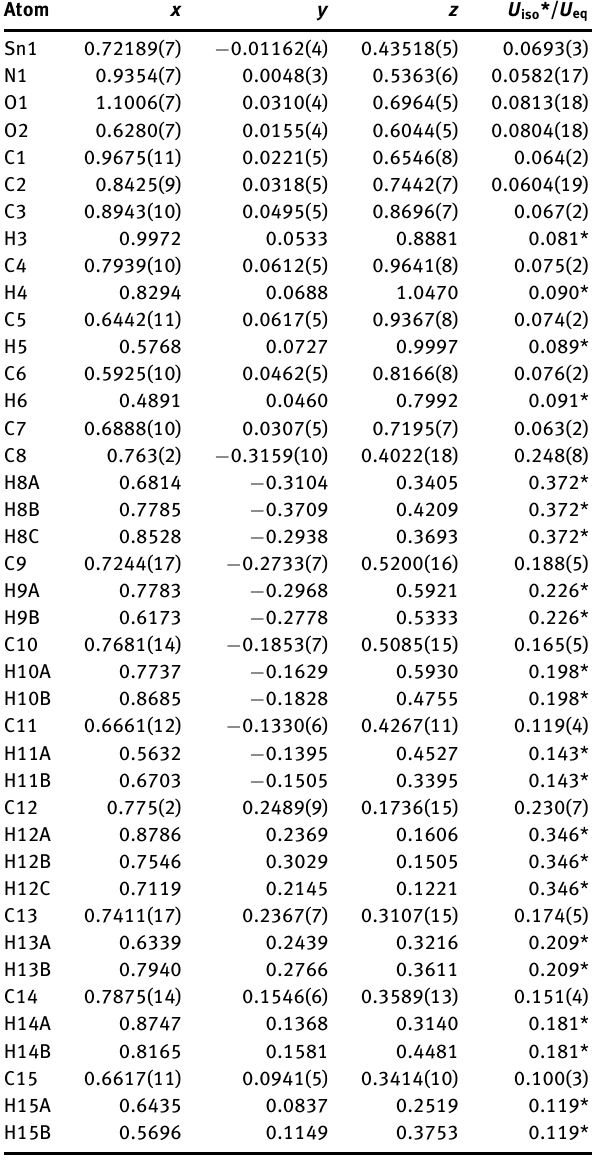
Table 2: Fractional atomic coordinates and isotropic or equivalent isotropic displacement parameters (Å 2 ).